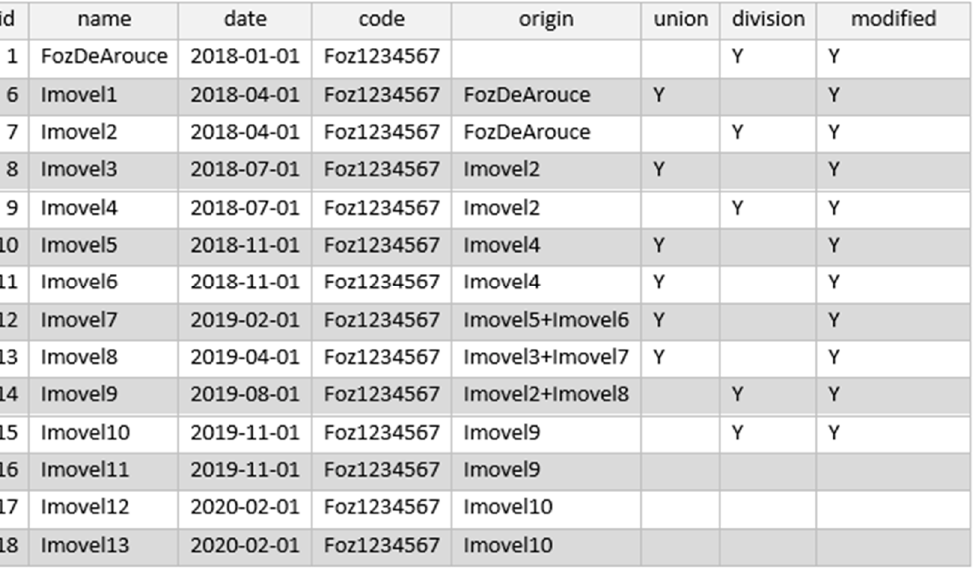
Figure 3. Property history example in QGIS.